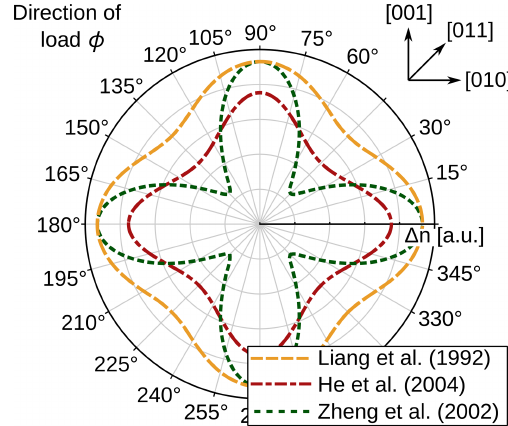
Figure 1. Comparison of different reported models for photoelas- ticity in silicon from the literature expressed as the difference (cid:49)n between the coefficients of refraction (the orientations of differently defined coordinate systems have been aligned).